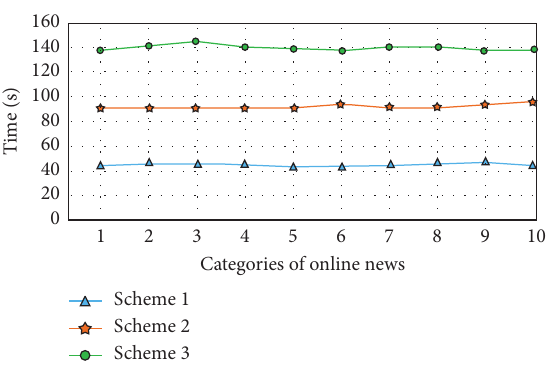
Figure 10: Comparison of three parallel schemes for keyword extraction.